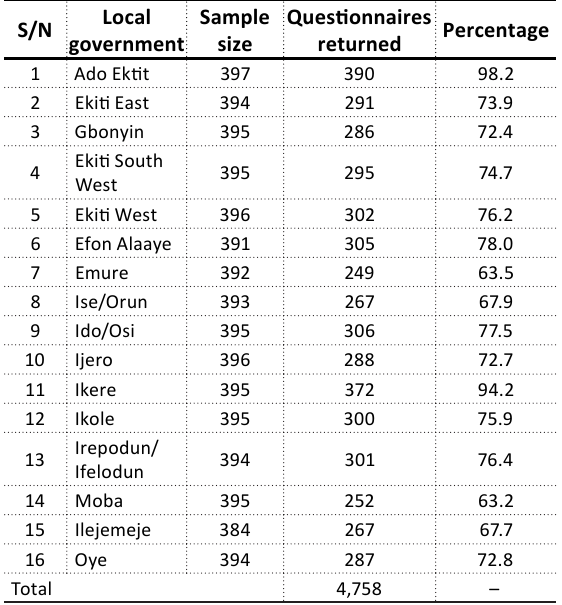
Table 2. Analysis of response rate by local